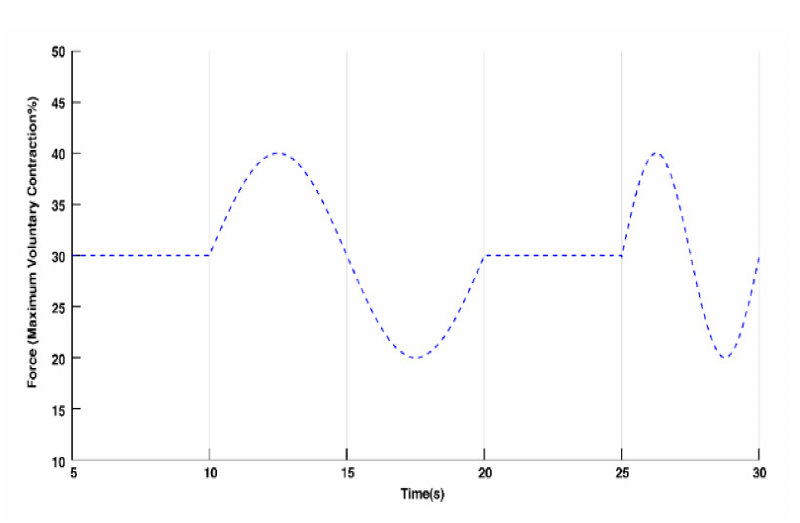
Figure 2. Target wave of 20–40% maximal voluntary contraction trial. The TW was normalized using the MVC value of each participant. There was a 5 s preparation period at the beginning to allow the participants to exert force to reach the TW ; thus, the data recording started at 5 s. Four independent sensors were placed at the distal phalanges of each participant’s four fingers to determine the vertical forces of individual fingers. At each time point, the real-time forces corresponding to the individual finger forces were normalized to a percentage of the MVC according to the MVC data for subject i and were recorded as the index-finger force ( IFF i ), middle-finger force ( MFF i ), ring-finger force ( RFF i ), and little-finger force ( LFF i ); then, a moving average with an interval of 15 samples was taken. The equation used to normalize finger force into the percentage of MVC is shown in Equation (2), taking the index finger as an example. In Equation (2) IFFraw i is the value of index finger force of subject i , MVC i is the largest MVC value of the subject i in two MVC trials.